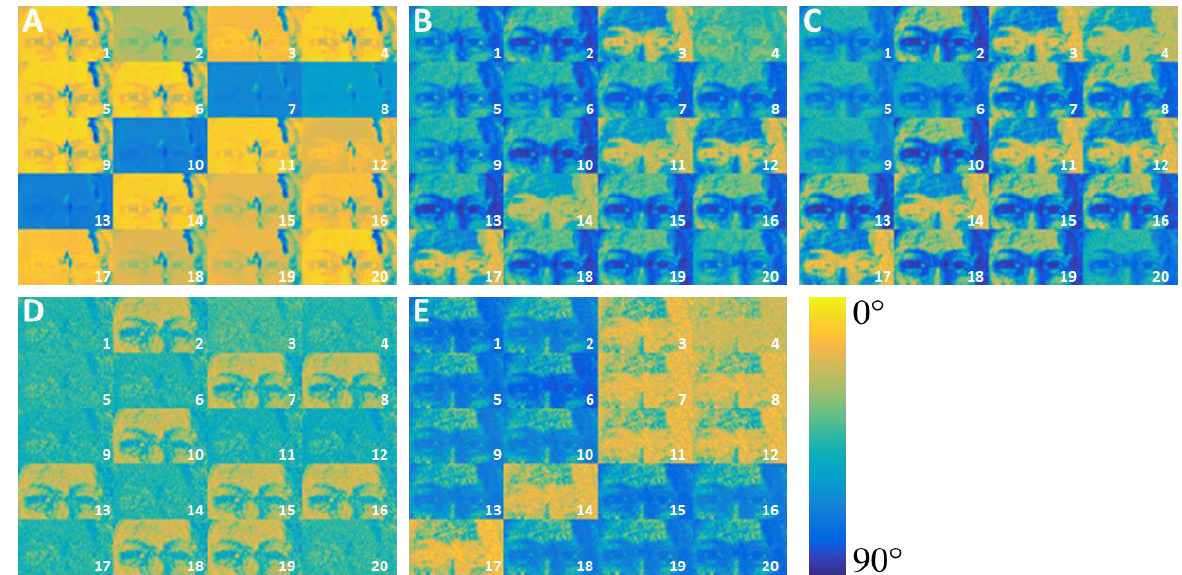
Figure 4. The sets of similarity maps, [𝐴] 𝑘 , for the reference panel obtained following the abundance criterion. The numbers within the panels refer to Table 1, the letters to Table 3. The color bar illustrates the level of similarity (expressed in terms of the angle between vectors). ( A ) shows [𝐴] 𝑘 , the set of similarity maps obtained without manipulating the spectra. ( B ) shows [𝐴] 𝑘 , obtained after that the channels related to 10.5 and 12.6 keV have been suppressed. ( C ) shows [𝐴] 𝑘 where the 9.2 keV peak has been removed too. ( D ) shows [𝐴] 𝑘 , the similarity maps after the removal of Fe related energies. ( E ), [𝐴] 𝑘 , shows what happens manually switching the order of removal for Hg and Fe.